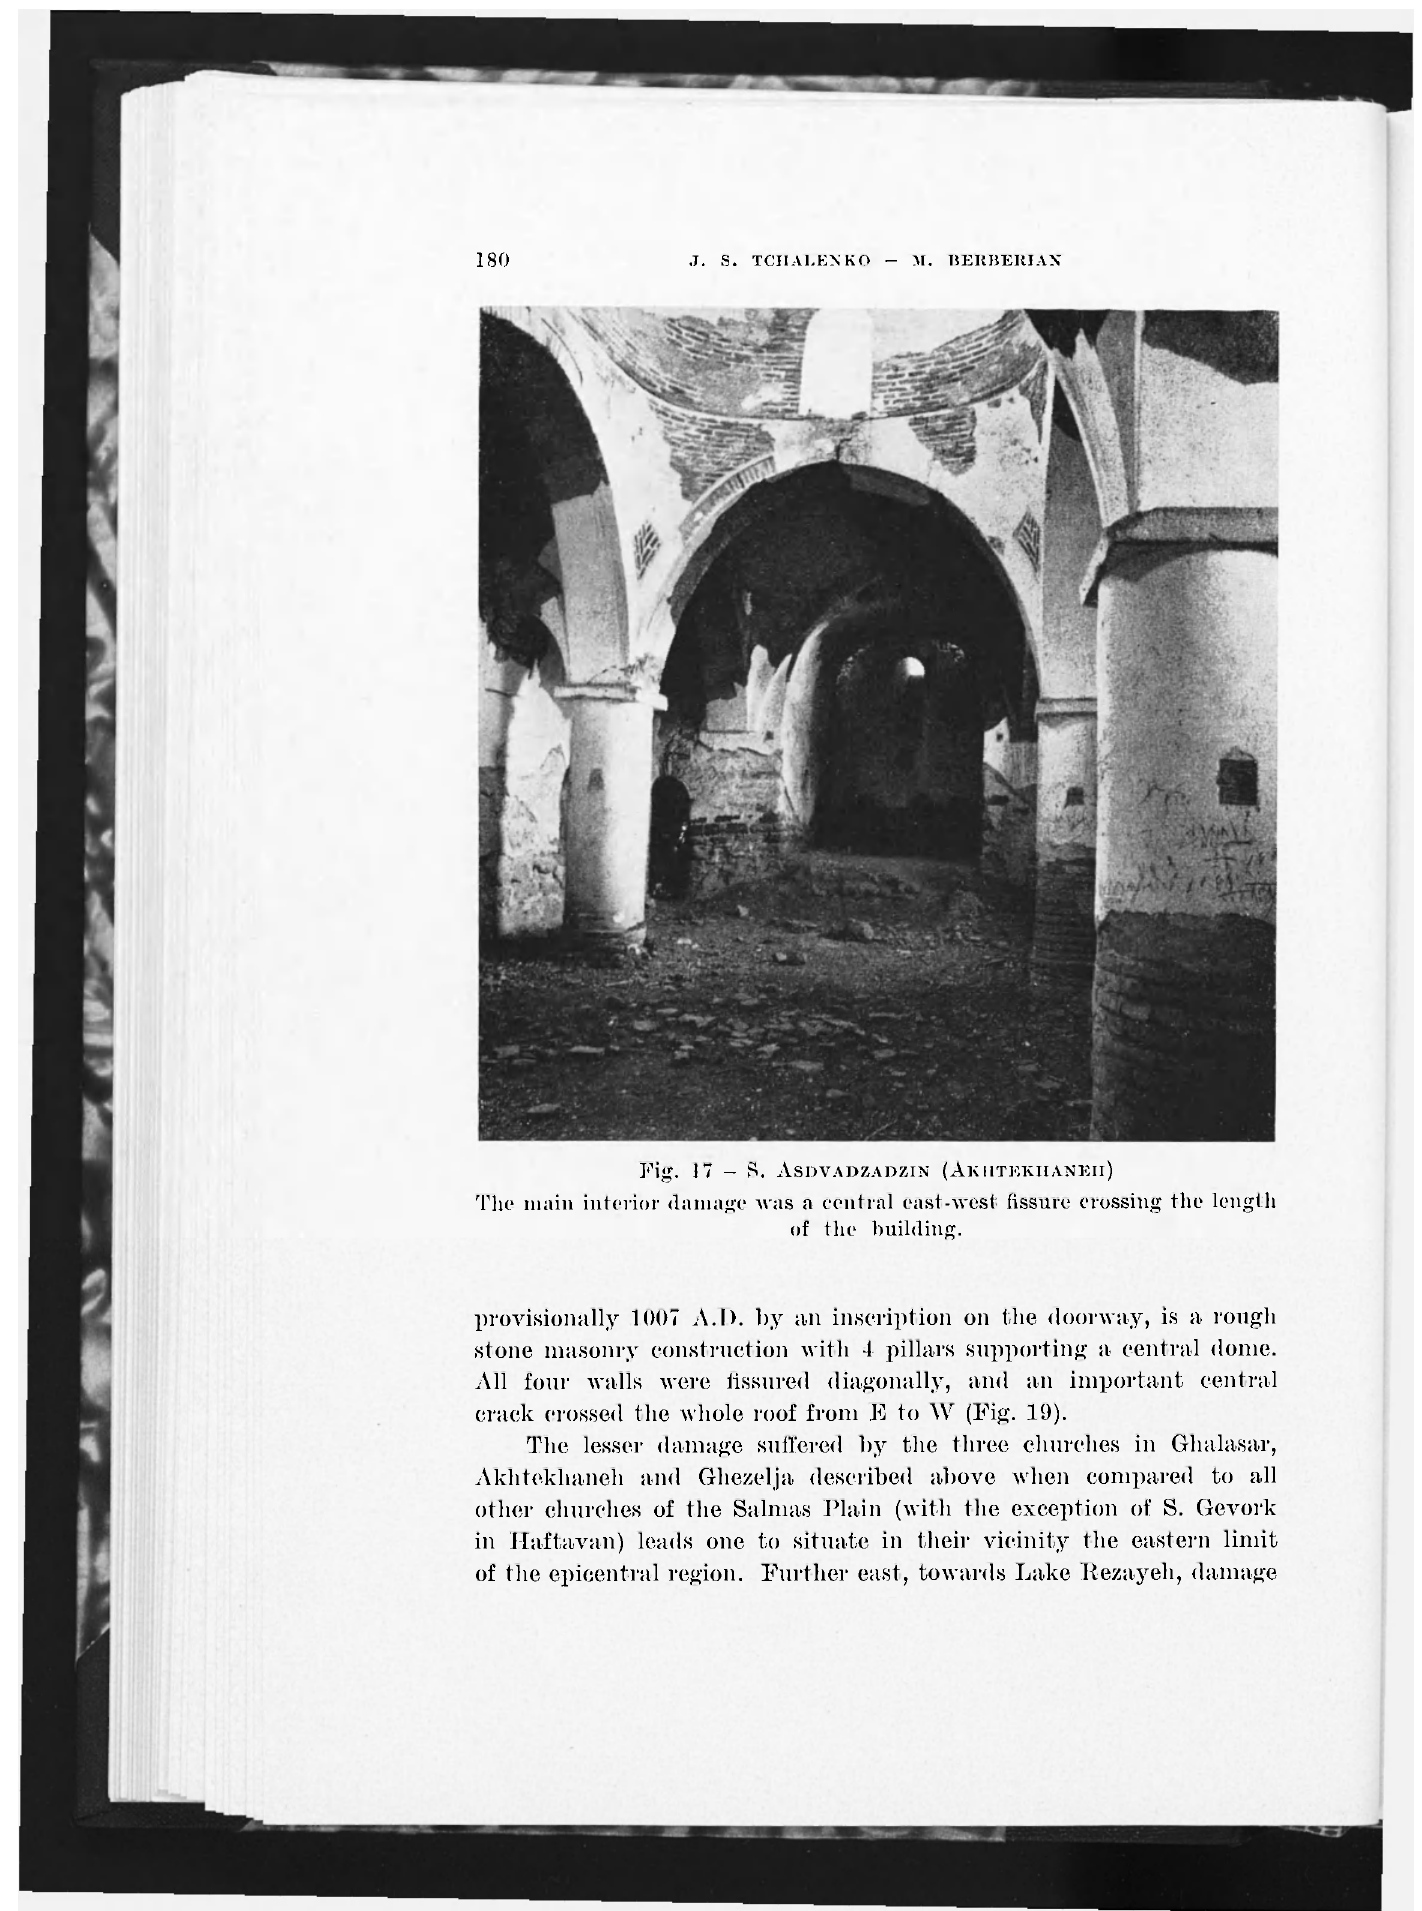
Fig. 17 - S. ASDVADZADZIN